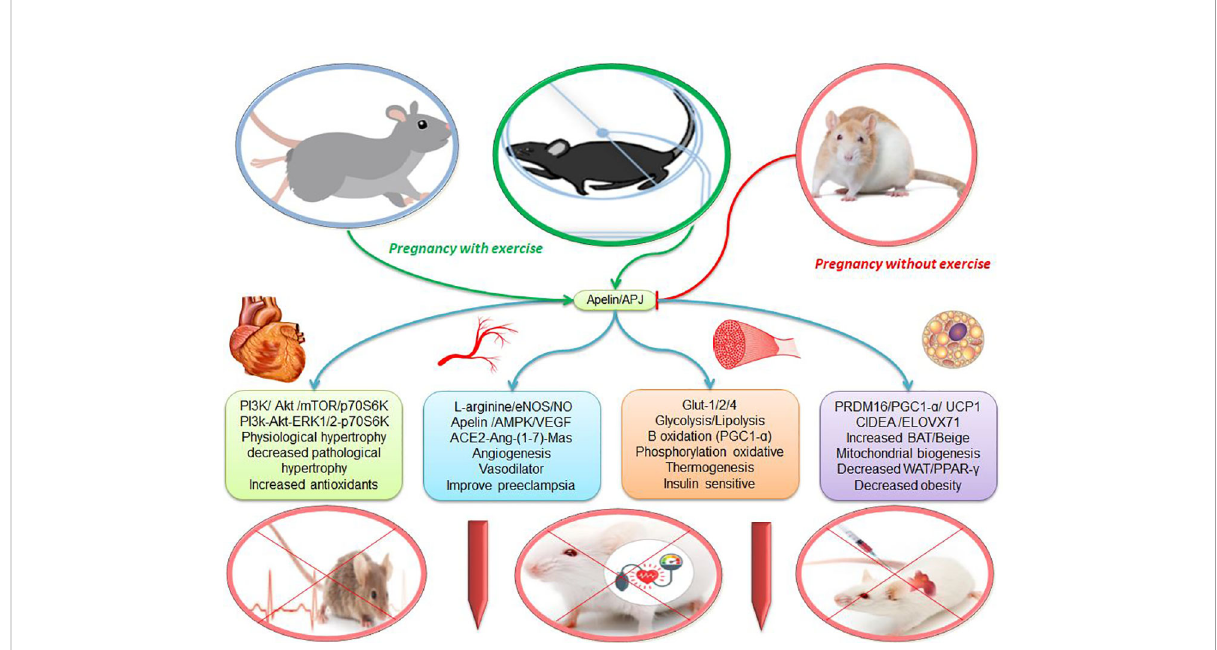
FIGURE 2 The effects of apelin and exercise on adipose tissue, muscle, vascular and heart. escription is available in the text. Abbreviations are given at the beginning of the